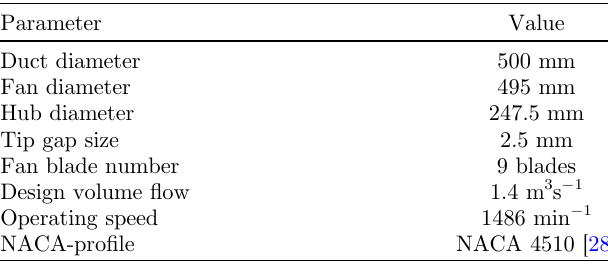
Table 1. Key characteristics of the axial